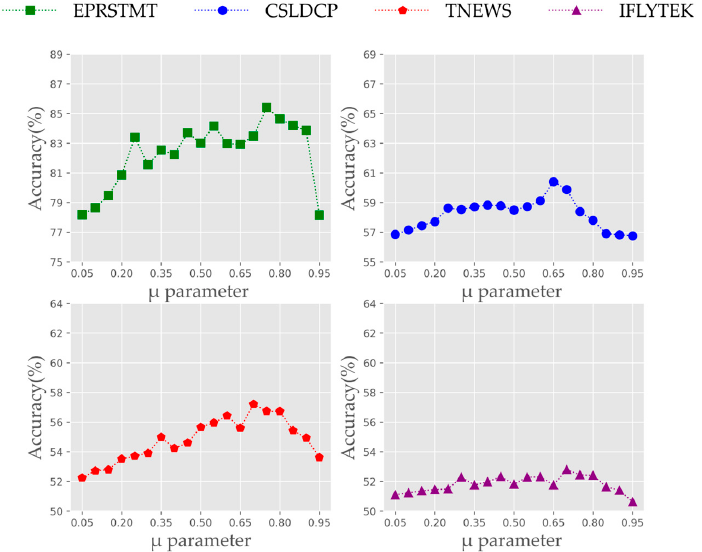
Figure 3. The influence of different μ parameters on the performance of our proposed model, CIPLUD.